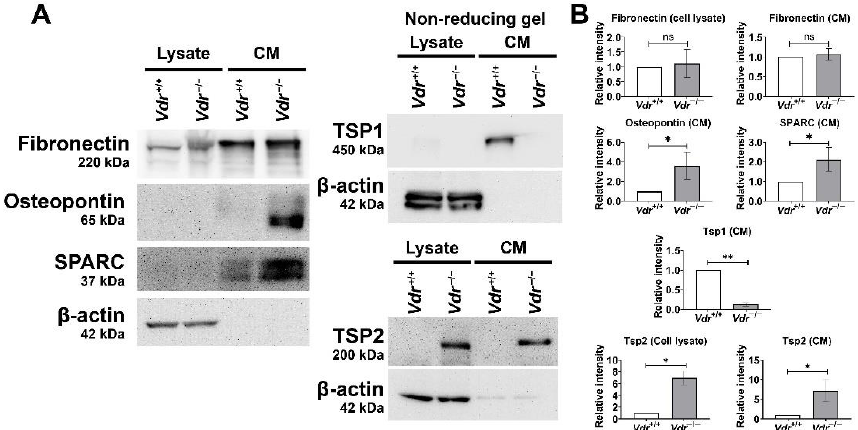
Figure 5. Altered expression of ECM proteins in Vdr − / − retinal EC. Retinal EC were incubated with serum-free culture medium for 48 h. The collected cell lysates (Lysate) and conditioned medium (CM) were analyzed by Western blot analysis for fibronectin, osteopontin, SPARC, TSP1, and TSP2 with specific antibodies ( A ) . The bands were quantified with densitometry and normalized by β - actin ( B ); n = 3 – 4, * p < 0.05, ** p < 0.01; ns: not significant).